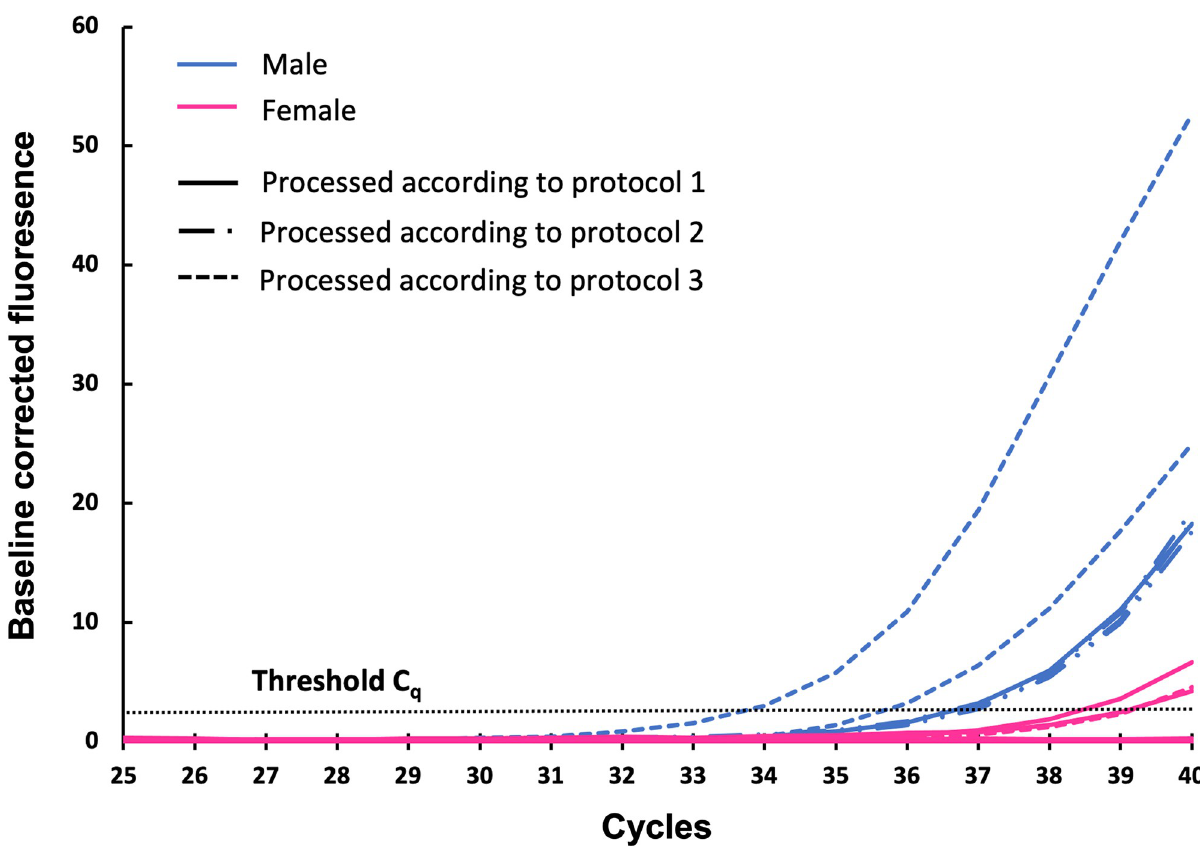
Fig 4. Baseline corrected fluorescent signal plotted against the cycle number. Male fetus samples are plotted in blue, while female fetus samples are marked in pink.